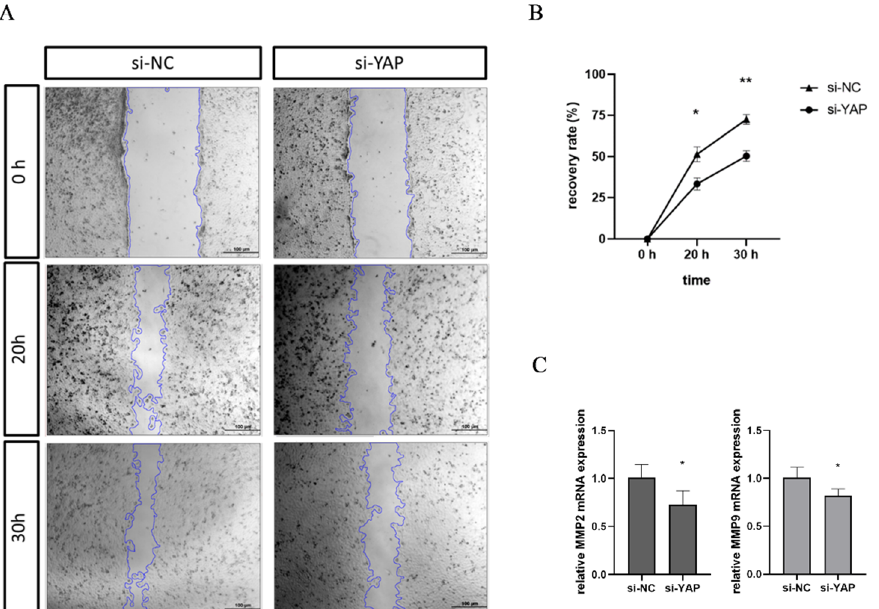
Figure 4. YAP knockdown impairs HTR-8 cell migration ability. ( A ) The wound healing assay was conducted between si-NC HTR-8 and si-YAP HTR-8 cells groups and the representative images were taken at 0 h, 20 h, and 30 h. Scale bars are 100 µ m. ( B ) The recovery rates of HTR-8 cells from the two groups are summarized. ( C ) The mRNA levels of MMP2 and MMP9 in HTR-8 cells transfected with control siRNA or YAP siRNA for 48 h were determined by RT-qPCR. Results are shown as mean ± SEM. Student’s t test; * p < 0.05, ** p < 0.01.